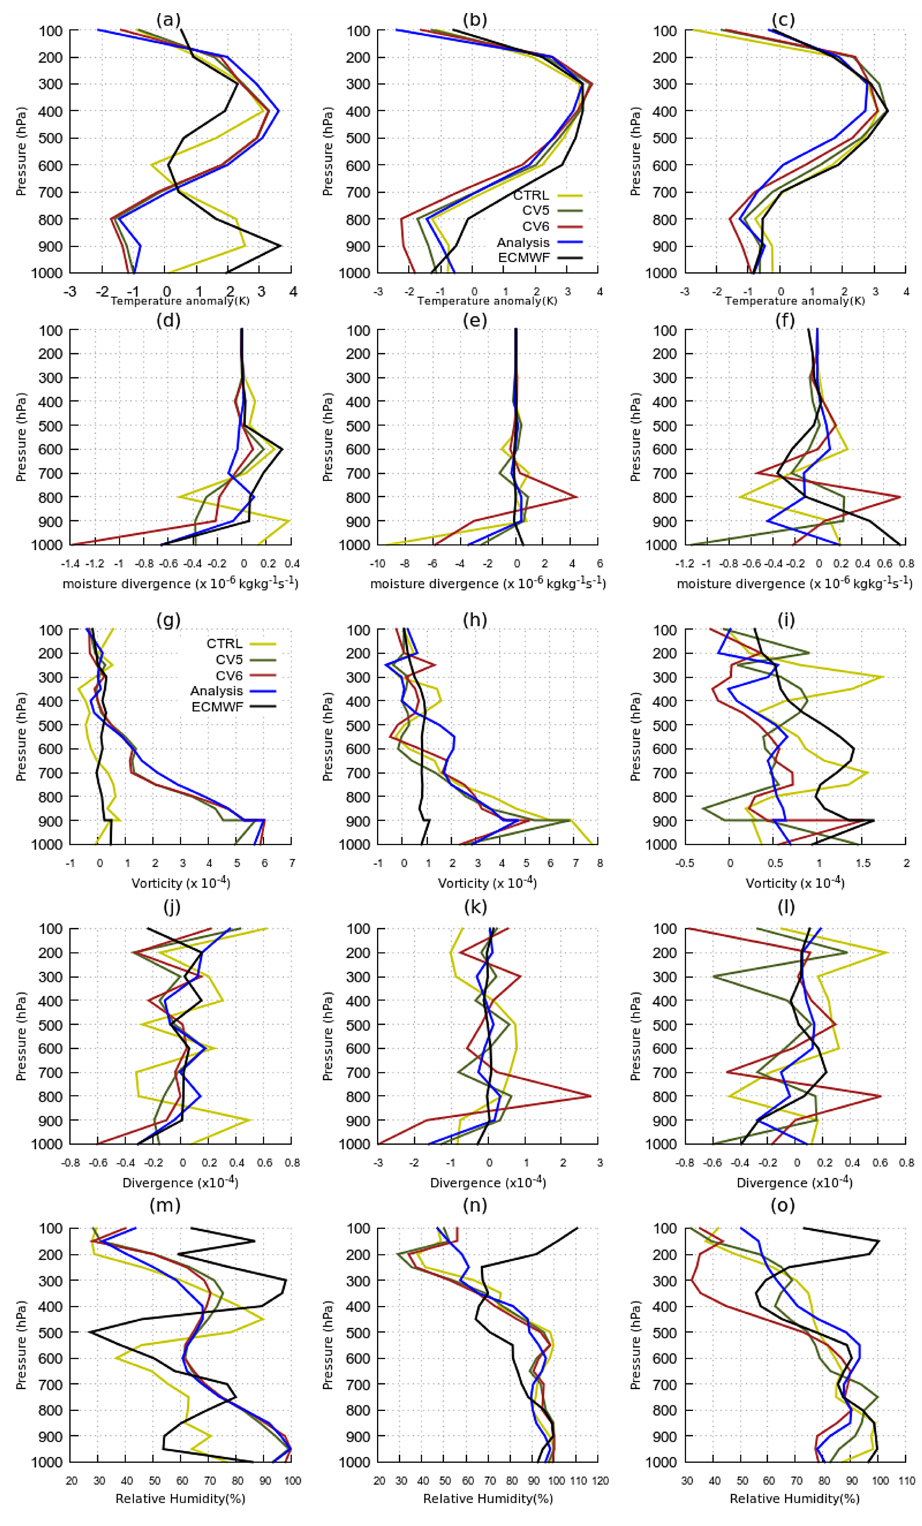
Figure 5. Vertical profiles of temperature anomaly (a, b, c) , moisture divergence (d, e, f) , relative vorticity (g, h, i) , horizontal diver- gence (j, k, l) and relative humidity (m, n, o) at the analysis time of the cv5/cv6 sensitivity experiments over the depression centre for case 1 (left column), case 2 (middle column) and case 3 (right column)